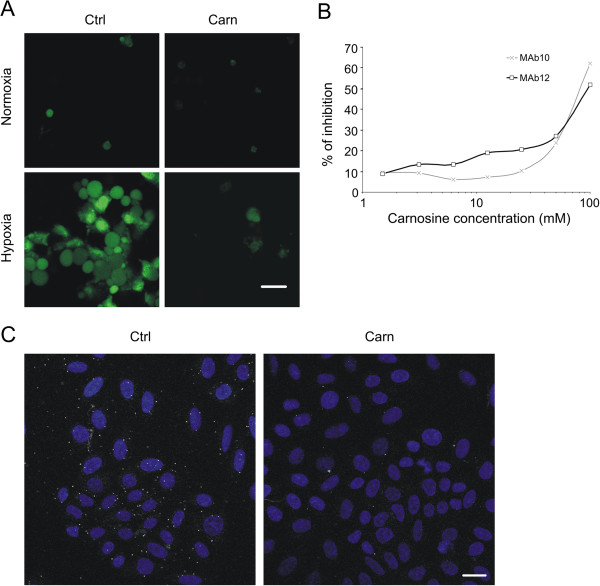
Carnosine impairs binding of CA IX-specific inhibitor and antibodies and affects formation of a CA IX metabolon. (A) Immunofluorescence signal of FITC-labeled CA specific inhibitor, which binds only to hypoxic cells with catalytically active CA IX, was markedly reduced after treatment of HeLa cells with 20 mM carnosine in hypoxia for 48 h. (B) Graph of competitive inhibition ELISA showing the percentage of inhibition after cultivation of HeLa cells with different concentrations of carnosine together with specific CA IX antibodies MAb10 and MAb12. Binding of antibodies to conformational epitopes in the catalytic domain of CA IX was inhibited by carnosine in a concentration-dependent manner. (C) SiHa cells cultured in islands under hypoxic conditions were analyzed by proximity ligation assay to visualize direct interaction between CA IX and the anion exchanger AE2 in the functional metabolon. The positive signal represented by bright white dots was considerably reduced in cells treated with 20 mM carnosine for 24 h, supporting the proposal that binding of carnosine alters the conformation of CA IX. Scale bar, 20 μm.